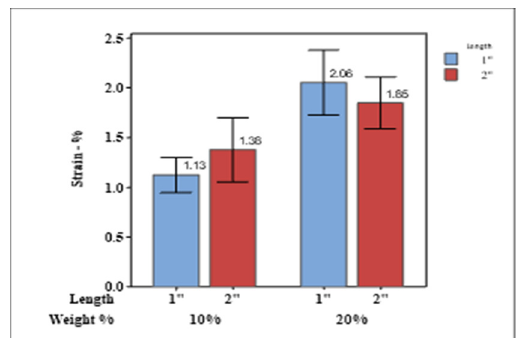
Fig. 6: Comparison of tensile strain of bagasse- reinforced composites samples